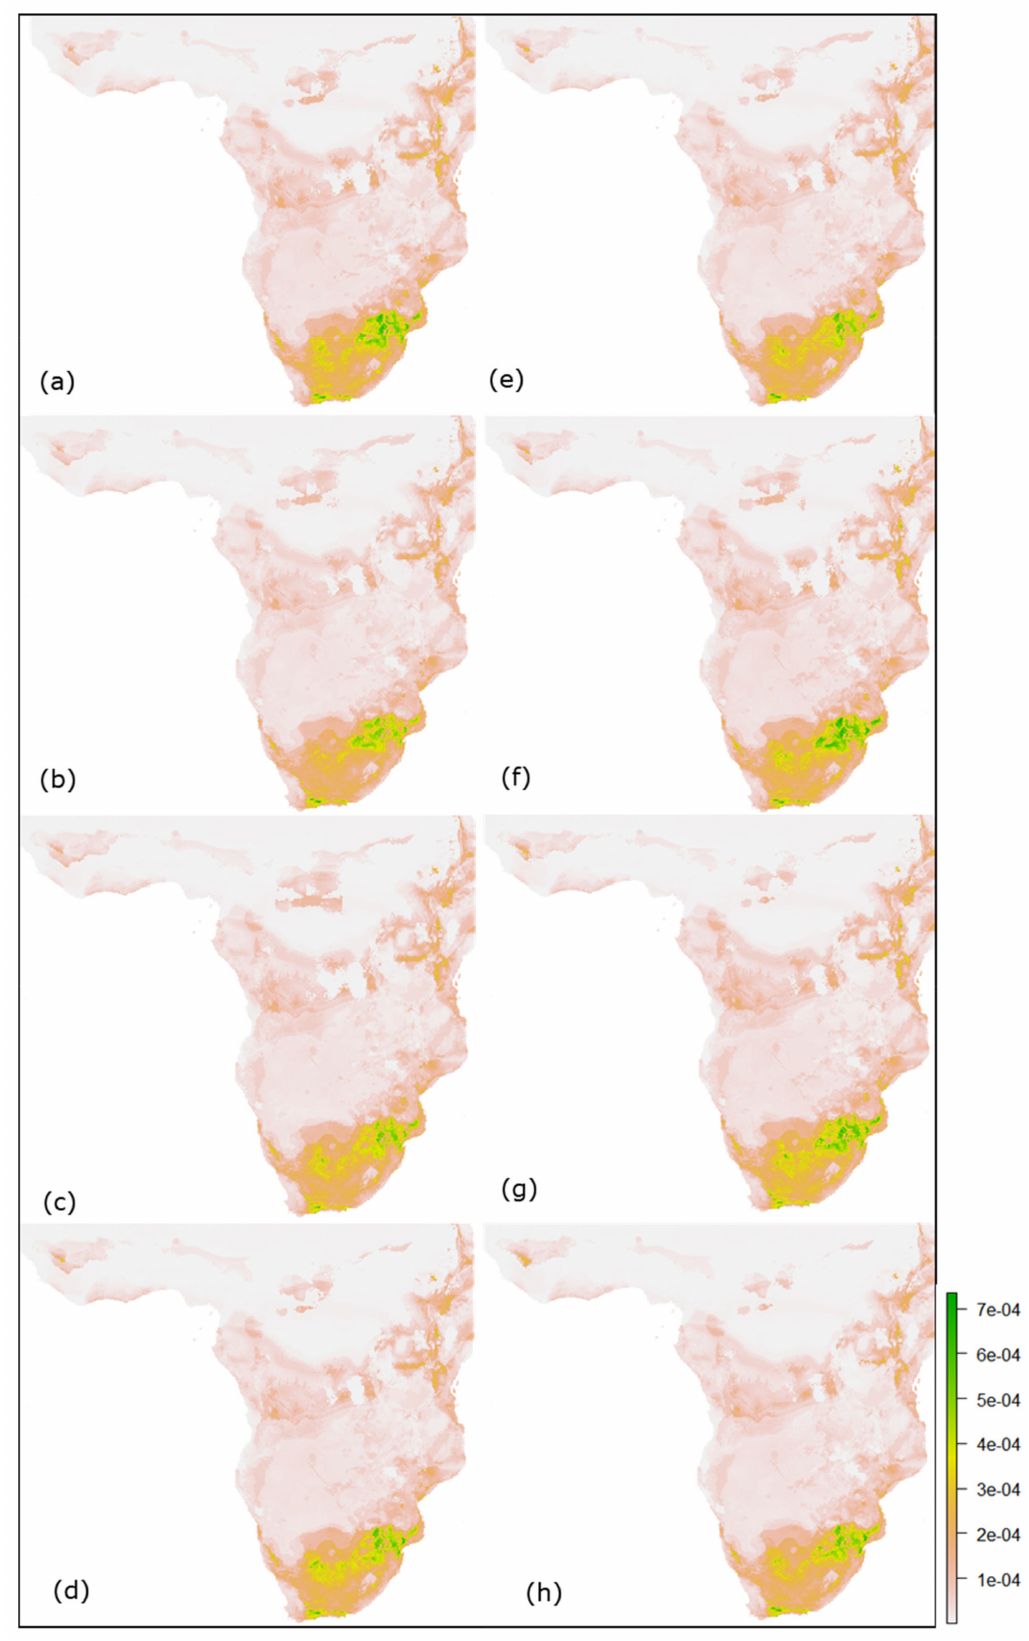
Figure 13. Predicted future suitability maps for January-May in Africa: ( a – d ) and ( e – h ) represent the SSPs 2.6, 4.5, 7.0 and 8.5 for 2030 and 2050,